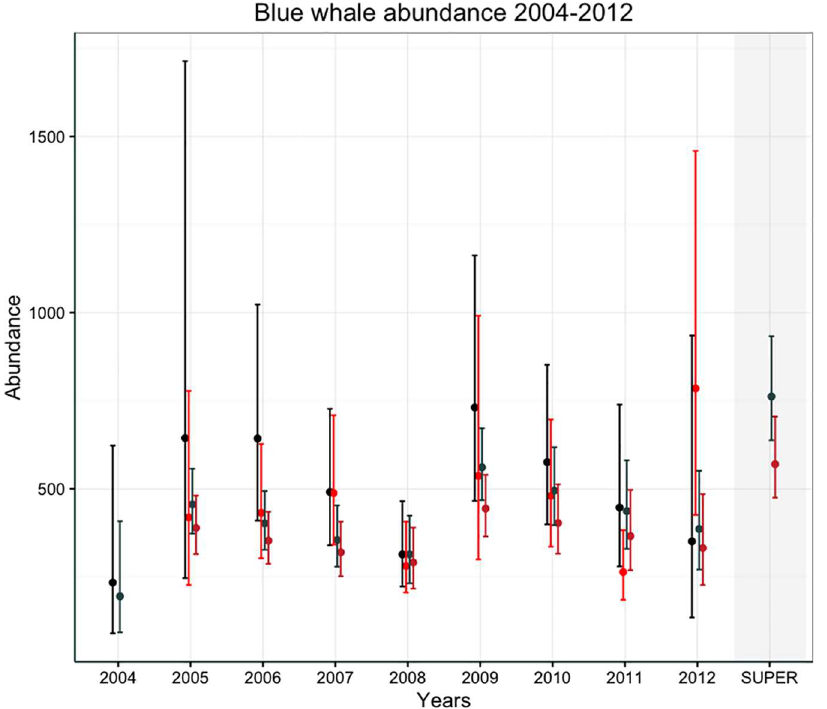
Fig 2. Estimatesof Chilean blue whale annual abundance from 2004–2012and POPAN superpopulation abundance (measured from January/February in each year). Estimates and 95% confidenceintervals are, from left to right, Pradel left sides (red), Pradel right sides (black), POPAN left sides (red), POPAN right sides (black), with POPAN superpopulation estimates for POPAN left and right sides